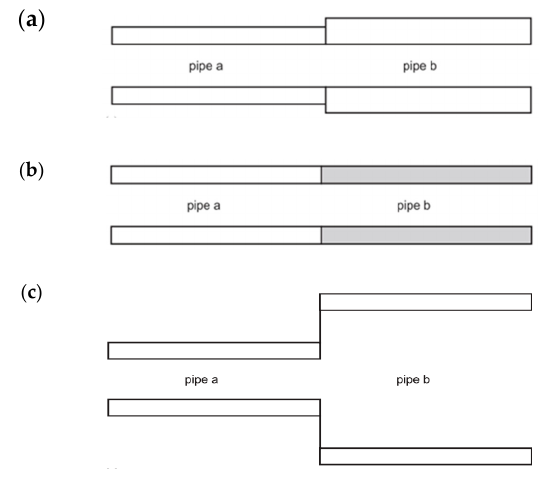
Figure 20. Axisymmetric pipe discontinuities: ( a ) wall thickness change; ( b ) wall elasticity change; ( c ) internal radius change [131], Copyright Elsevier, 2005.